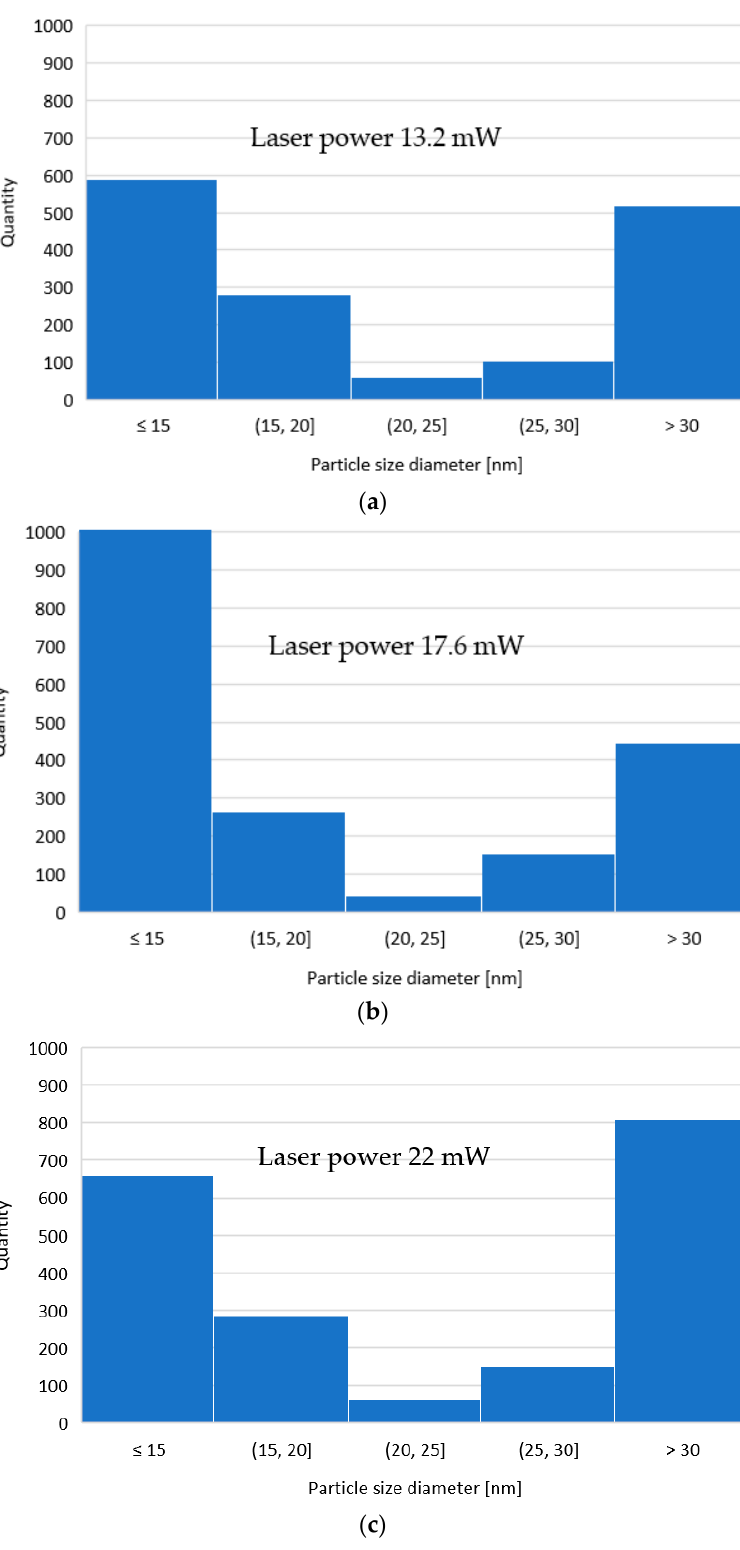
Figure 11. Histograms of particles distribution: ( a ) 4 mW; ( b ) 15 mW; ( c ) 16 mW.